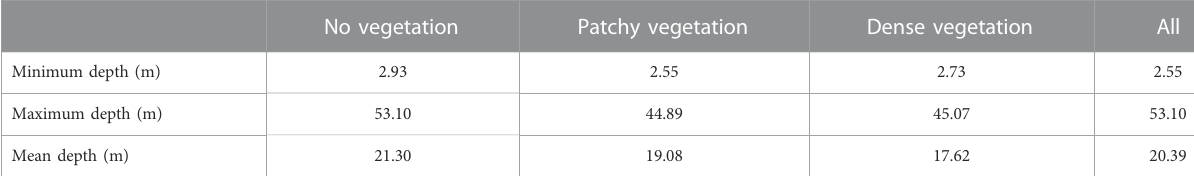
TABLE 2 Depth summaries of vegetation density likelihood classes on hard substratum (sand excluded).